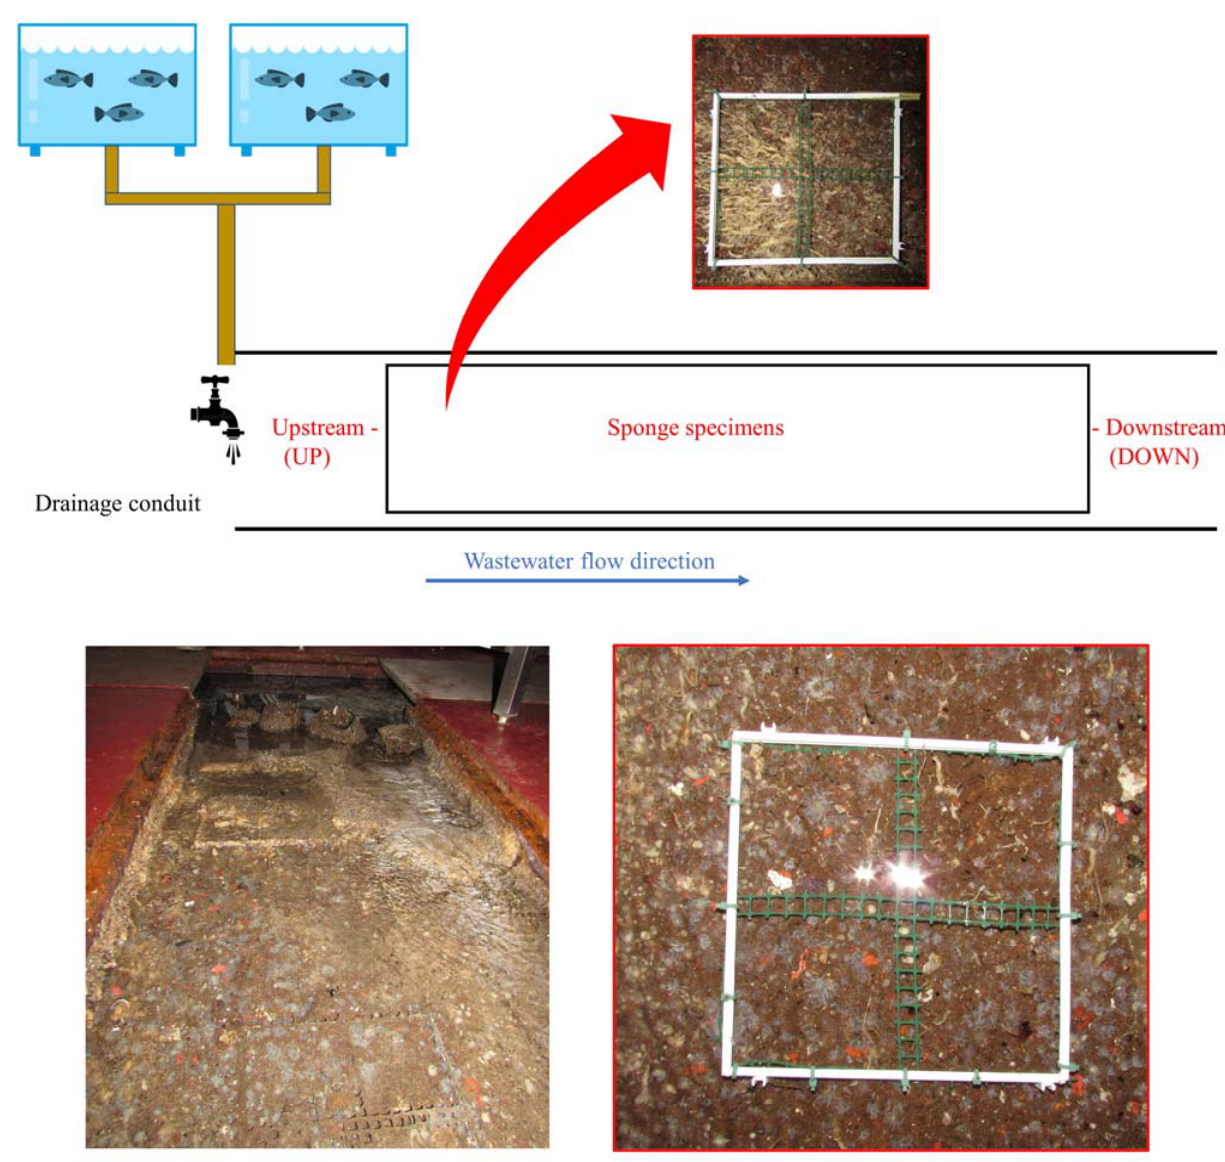
Figure 1. Schematic drawing (not in scale) and real picture of the wastewater drainage conduit where the sponge, Hymeniacidon perlevis, lives, as well as an indication of the wastewater collection points: upstream (UP) and downstream (DOWN). In the red box, picts of H. perlevis with a polyvinyl chloride (PVC) frames utilized for sponge volume measurement.